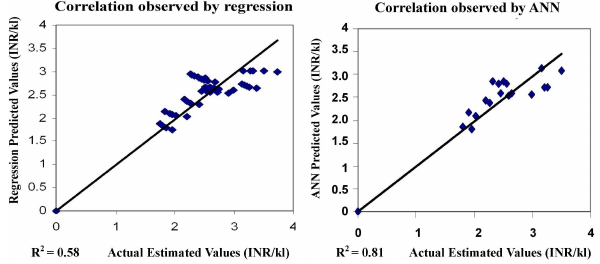
Figure 5. Relationships among cost, land rent, distance from GRWW and Tributary